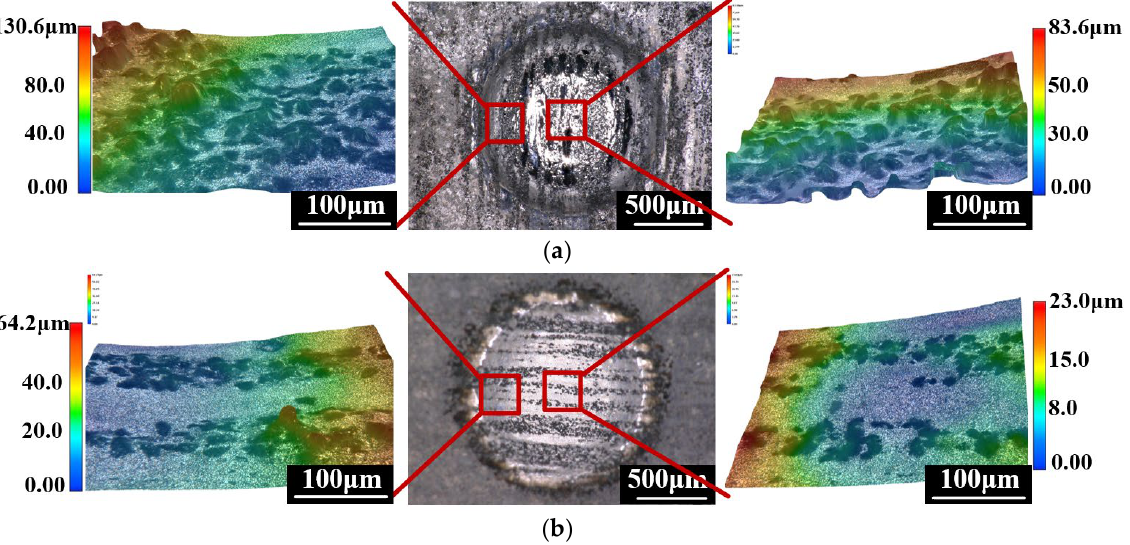
Figure 6. Comparison of microstructures at the processing voltage of 40 V: ( a ) JECM; ( b ) PAJECM.